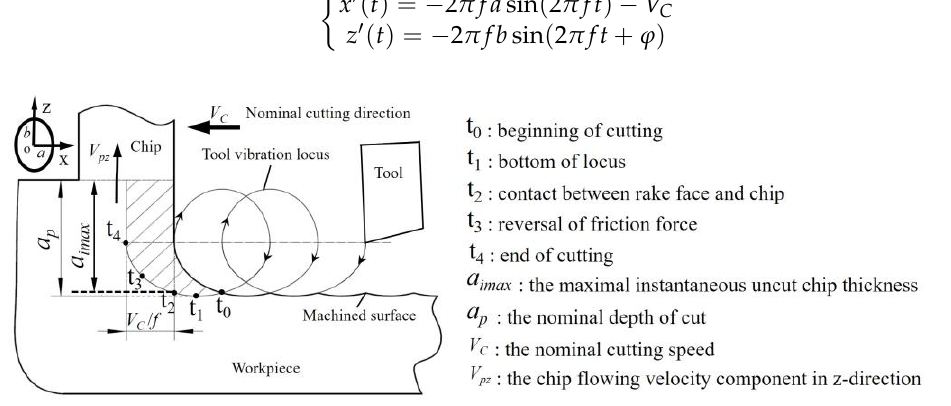
Figure 1. Schematic diagram of UEVC.